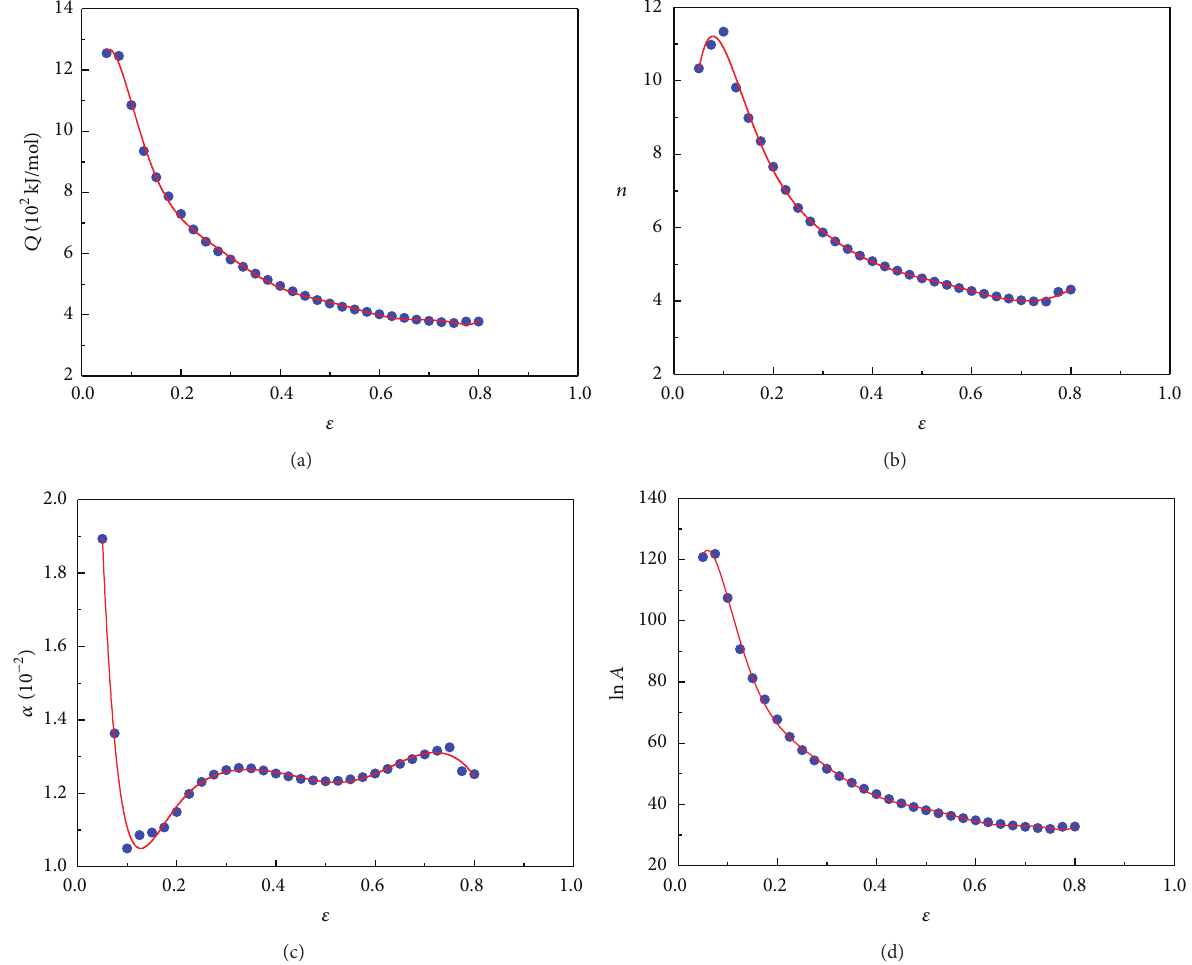
Figure 3: Relationship between (a) Q , (b) n , (c) 𝛼 , (d) ln 𝐴 and true strain by polynomial fit of 20MnNiMo